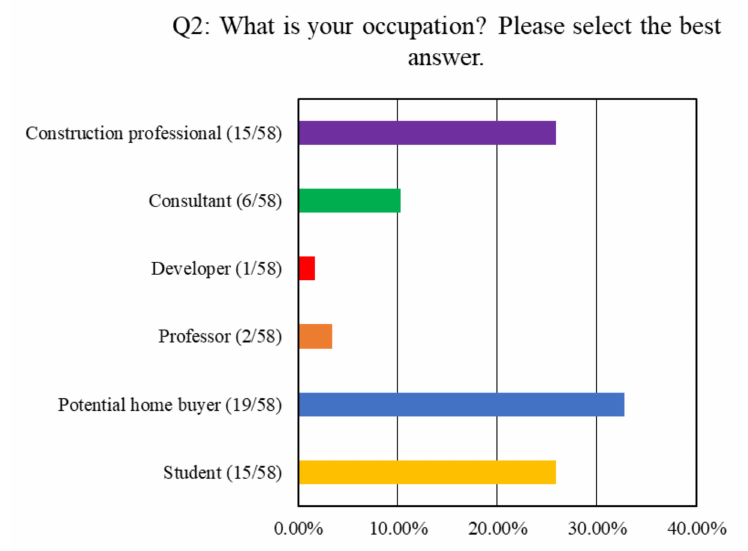
Figure 3. Participants’ occupation and potential home buyers.